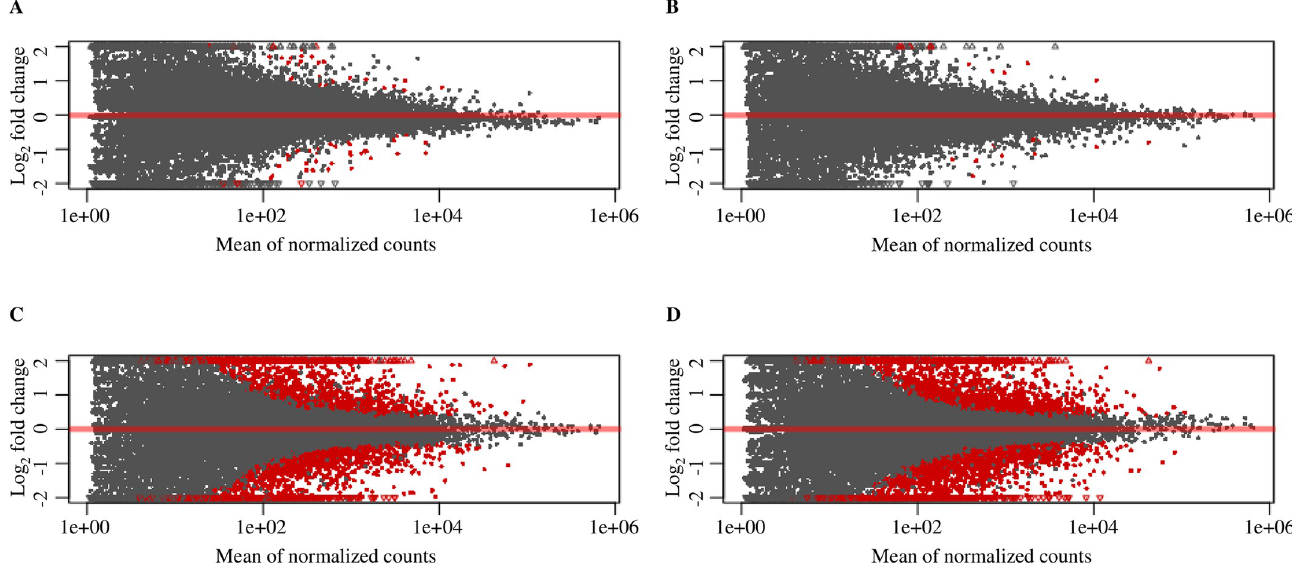
Fig 4. MA plots produced using DESeq2 for differential expression analysis in four comparisons. The x-axis shows the mean normalized read counts and the y-axis shows log 2 fold changes. Points in red show significant DEGs (Padj � 0.05). The positive area shows upregulated genes and the negative area shows downregulated genes. (A) In Rec genotype, between Cd stress and CK treatment (Rec.Cd vs Rec.CK), (B) in Dom genotype, between Cd stress and CK treatment (Dom.Cd vs Dom.CK), (C) between the two genotypes and under Cd treatment (Rec.Cd vs Dom.Cd), and (D) between the two genotypes and under CK treatment (Rec.CK vs Dom.CK). CK: Control.